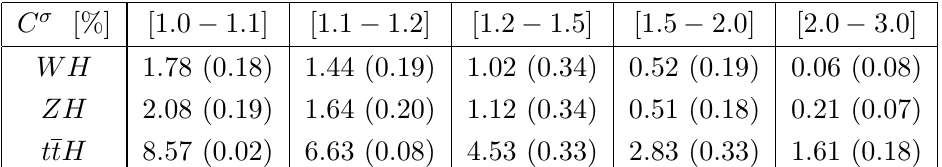
Table 6 . Coe(cid:14)cients parametrizing the corrections to the di(cid:11)erential Higgs production cross sections at 13 TeV in the WH , ZH and ttH channels due to loops involving the Higgs self-coupling (see eq. (A.13)). The bins extrema are expressed in units of m threshold , de(cid:12)ned as m threshold (cid:17) m V + m h for WH and ZH , and m threshold (cid:17) 2 m t + m h for ttH . In parentheses we give the fraction of events belonging to each bin in the SM distribution. The results are taken from ref. [6].